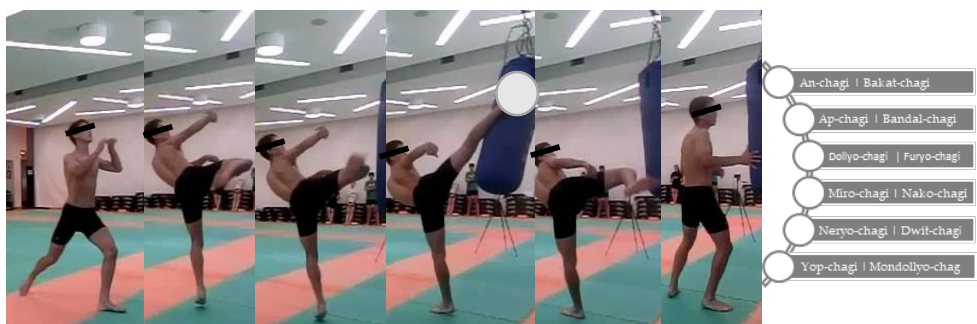
Figure 1. Six variables of the frame